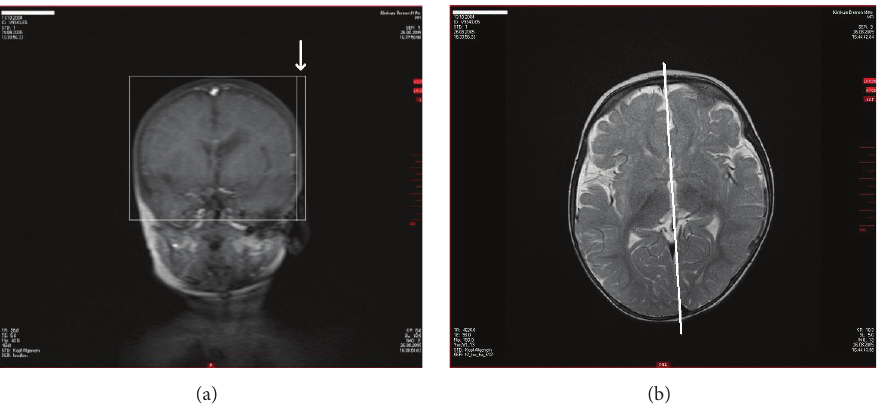
Figure 3: MRI of the head (M.H.) at 10 months of age (2005). (a) Significant depression of parietal bone left in a.p. projection (molding, arrow) (1.5-Tesla Avanto, head coil array, T1w TSE sequence). (b) Obvious volume reduction of the left hemisphere by birth trauma